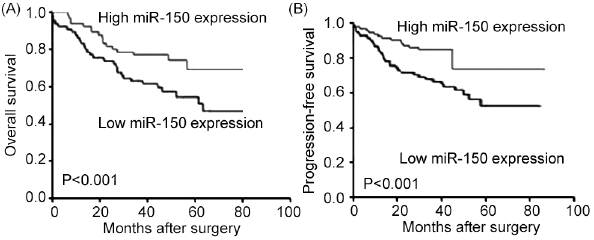
Figure 2. Kaplan–Meier overall (A) and progression-free (B) survival curves for epithelial ovarian cancer patients with high and low miR-150 expression. Epithelial ovarian cancer patients with low miR-150 expression had significantly shorter overall (P , 0.001) and progression-free (P , 0.001) survival than those with high miR-150 expression